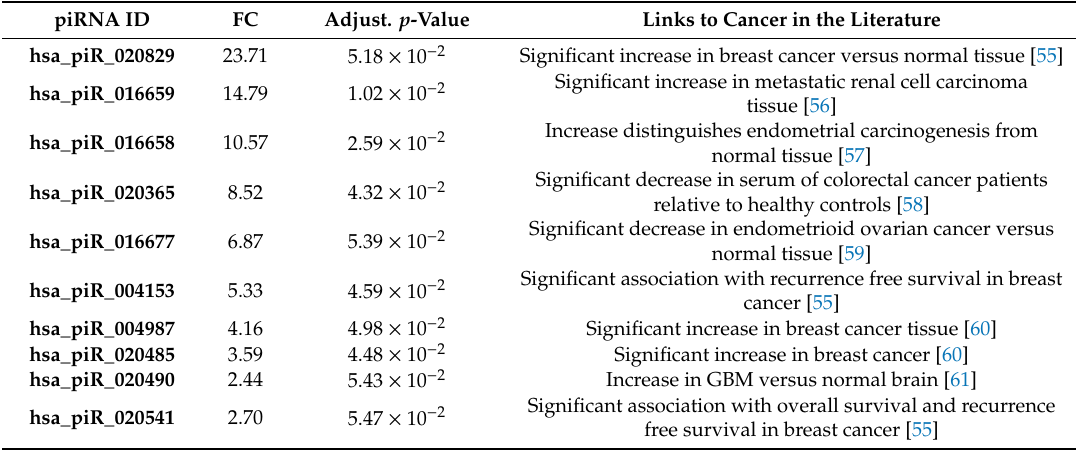
Table 1. Significant piRNAs with increased expression in GBM CUSA-EVs are previously associated with